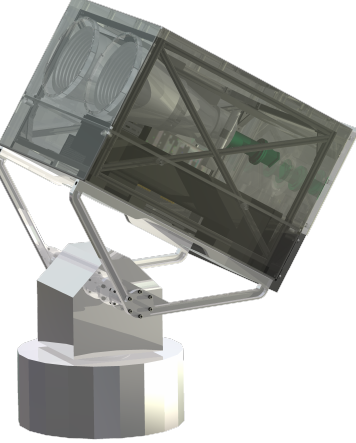
Figure 1. Artist’s rendering of DLR’s new C-band Kalibri transponder, mounted on a two-axis